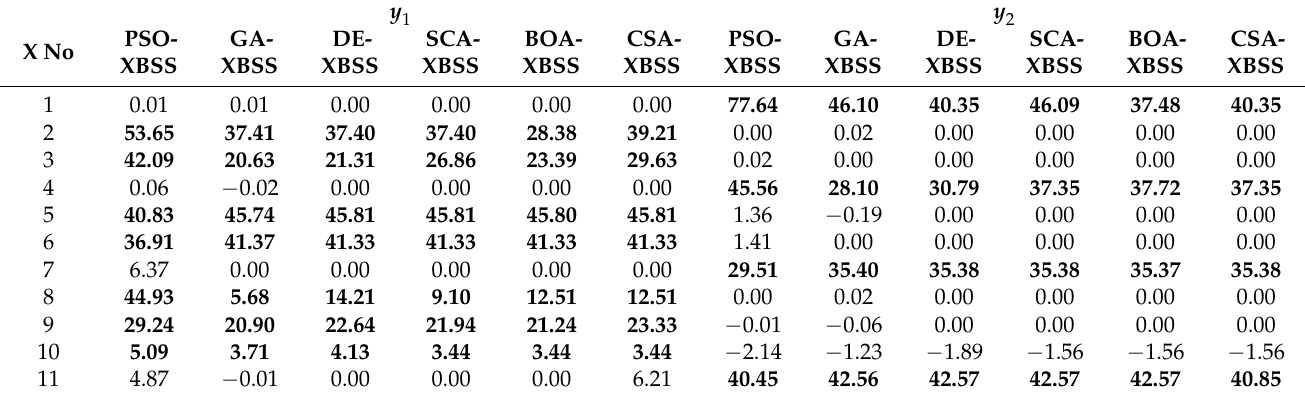
Table 4. Improvement details of mean value of SI-SDR of y 1 and y 2 in groups 1 to 17.